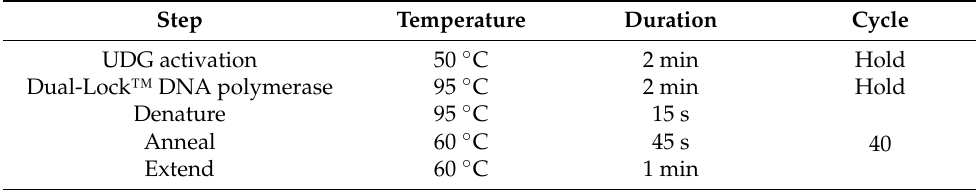
Table 6. qRT-PCR conditions PowerUp™ SYBR™ Green Master